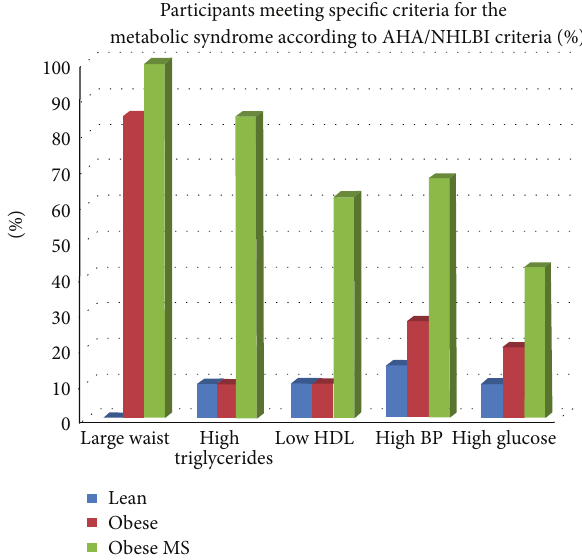
Figure 2: Prevalence of individual components of the metabolic syndrome among study groups based on the AHA/NHLBI criteria.